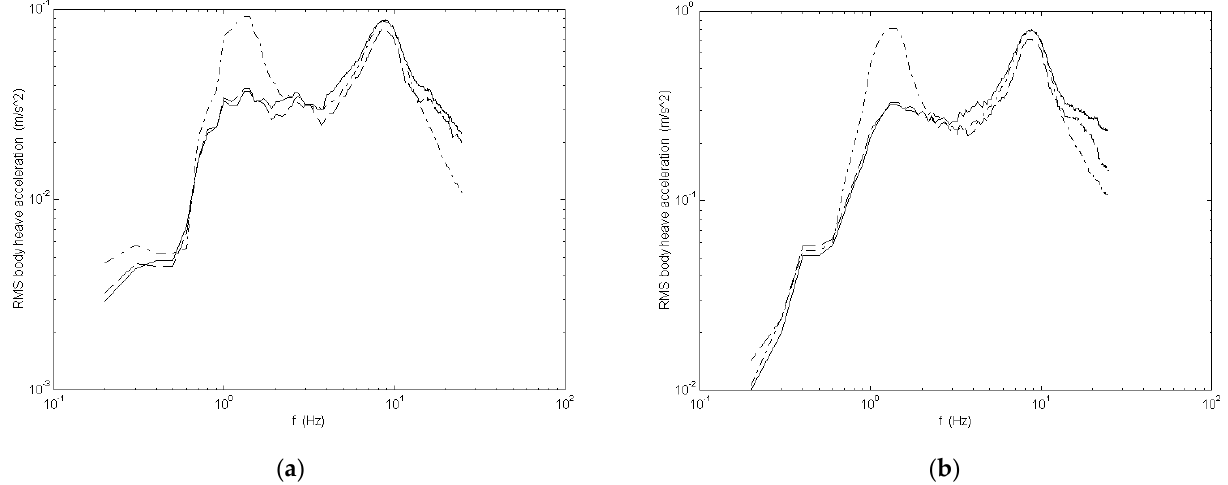
Figure 6. RMS of chassis heave acceleration. ( a ) smooth road; ( b ) rough road.